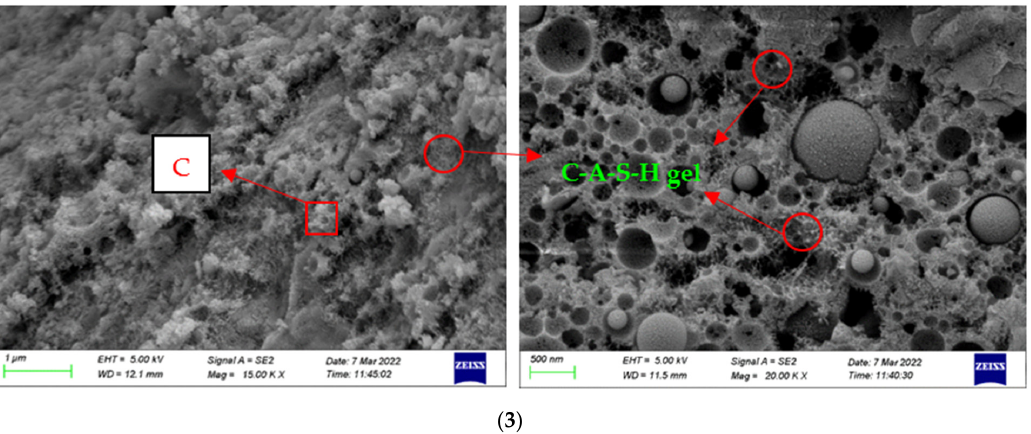
Figure 9. SEM image of modified composite gel material. ( 1 ) Slag-modified sample. ( 2 ) Fly-ash modified sample. ( 3 ) Silica fume-modified sample. Table 2. Average molar ratio of basic elements at sample points A, B, and C in Figure 9.